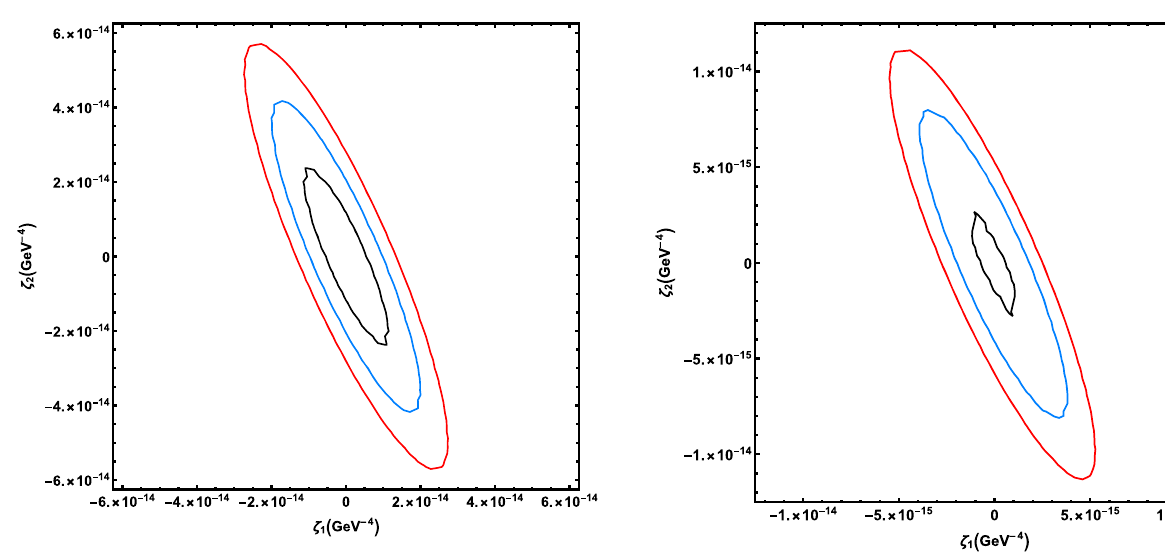
Fig. 6 The 95% C.L. exclusion regions for the couplings ζ 1 ,ζ 2 for the unpolarized light-by-light scattering at the CLIC with the systematic errors δ = 0% (black ellipse), δ = 5% (blue ellipse), and δ = 10% (red ellipse). The inner regions of the ellipses are inaccessible. The collision √ s = 1500 GeV, the integrated luminosity is L = 2500 fb − 1 . energy is The cut on the outgoing photon invariant mass m γγ > 1000 GeV was imposed